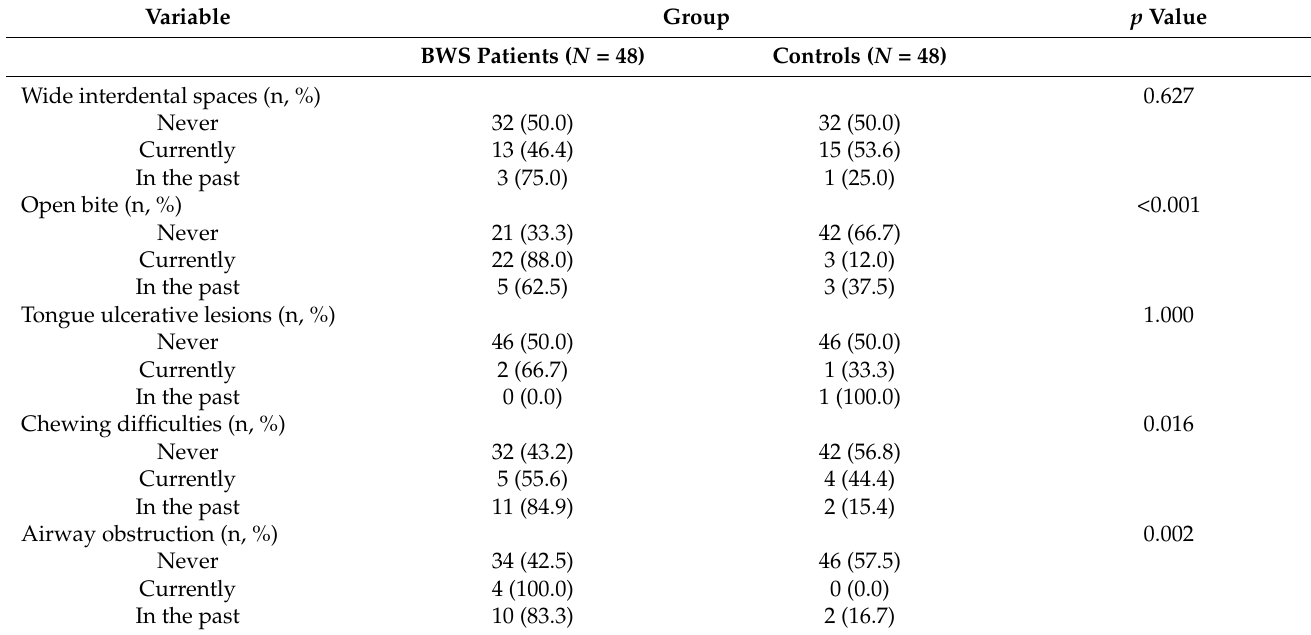
Table 3. Oral and related functional aspects by